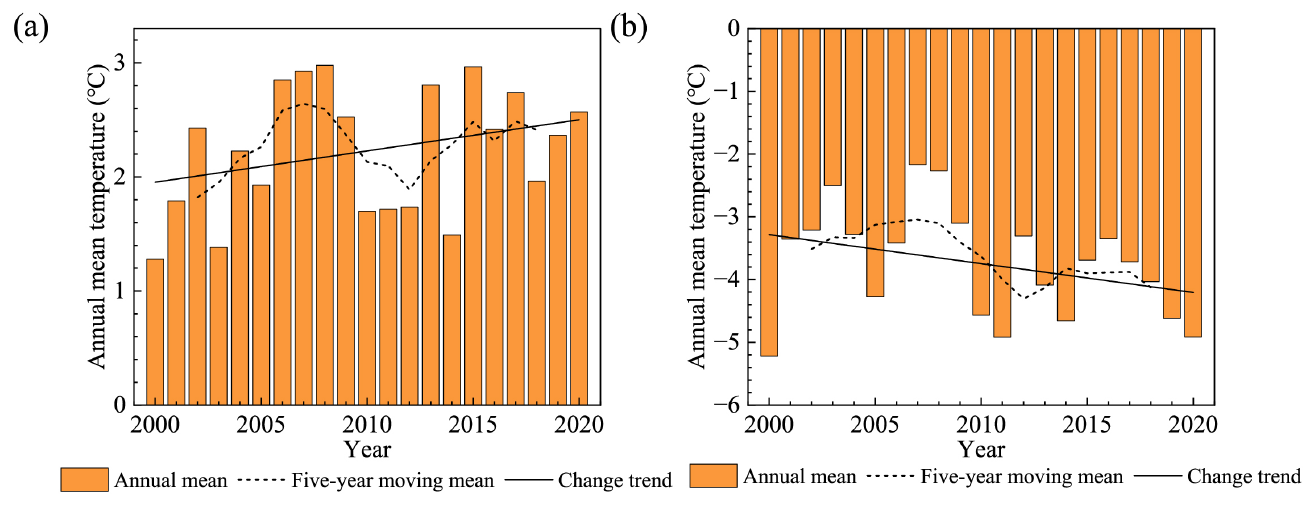
Figure A2. Temperature in the upstream basins of lakes from 2000 to 2020 ( a ) Manas Lake; ( b ) Bosten